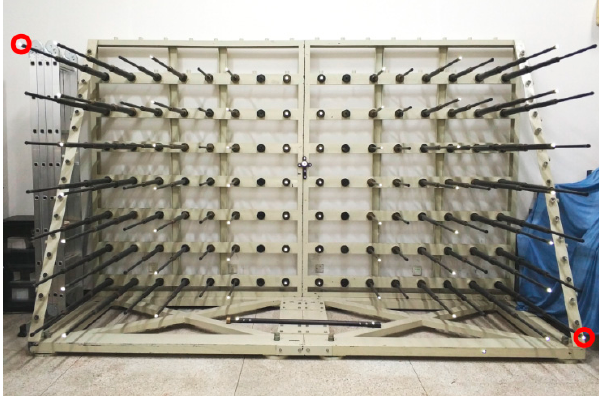
Figure 13. The 3D object used for the comparison experiment.